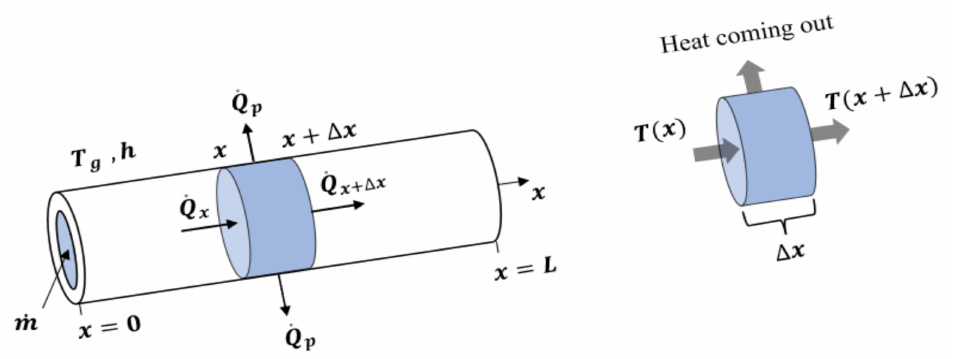
Figure 3. The rate of heat transfer through the pipe’s surface to the